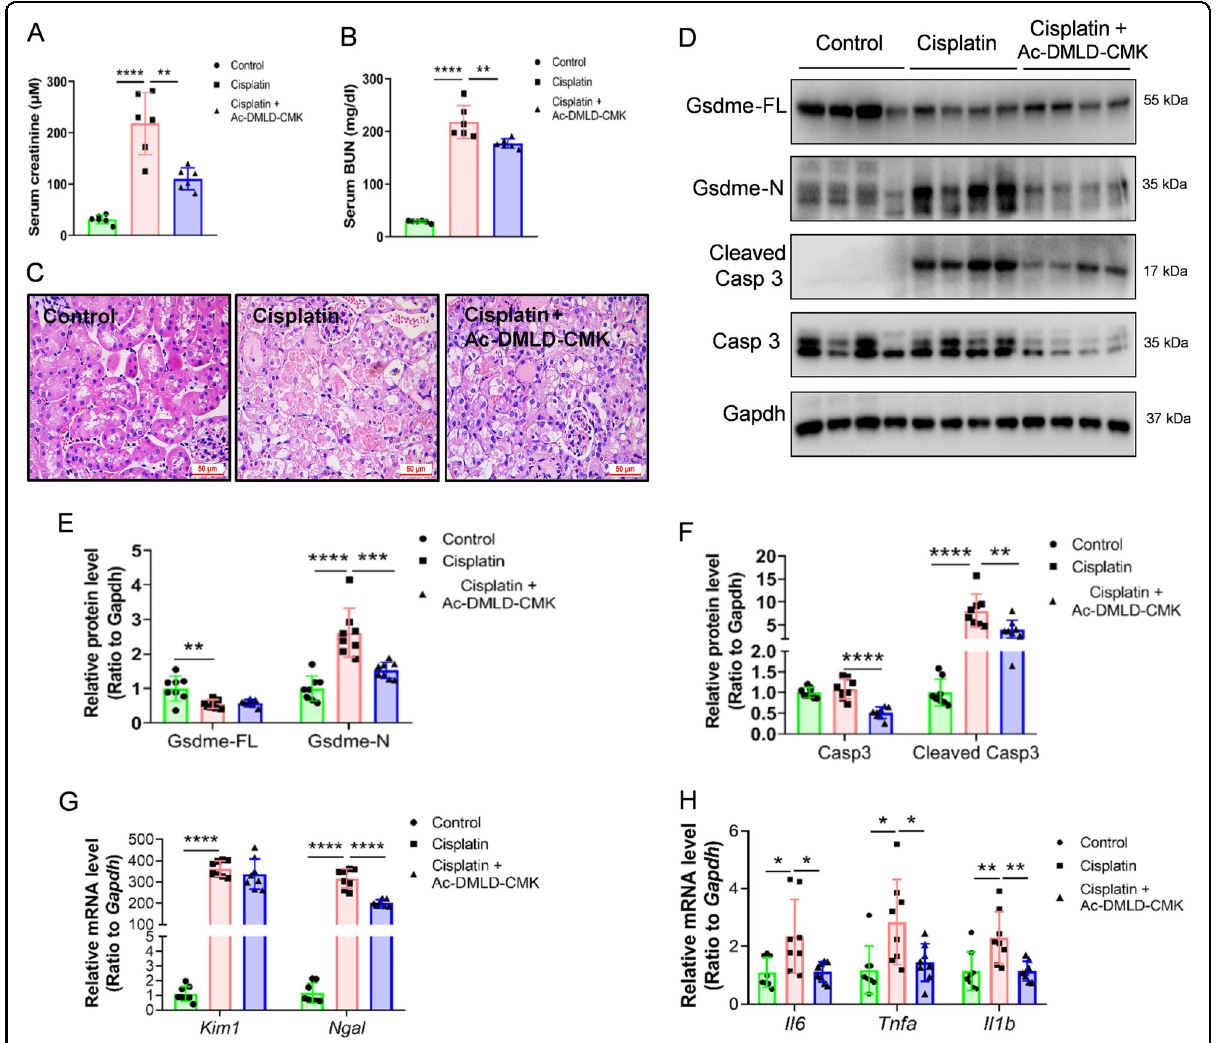
Fig. 5 Ac-DMLD-CMK decreases cisplatin-induced renal pyroptosis in vivo. A , B Serum creatinine and BUN detected in cisplatin-treated mice before or after Ac-DMLD-CMK pre-treatment. C HE staining of cisplatin-treated mice before or after Ac-DMLD-CMK pre-treatment. Scale bar, 50 μ m. D – F Western blot analysis of GSDME and caspase 3 in cisplatin-treated mice before, or after, Ac-DMLD-CMK pretreatment. G , H mRNA expression of kidney injury-related genes and in fl ammatory-related genes in cisplatin-treated mice before, or after, Ac-DMLD-CMK pretreatment. All data are shown as means ± SD from six independent experiments ( n = 6). * p < 0.05, ** p < 0.01, *** p < 0.001, **** p < 0.0001 using one-way ANOVA followed by the Tukey ’ s